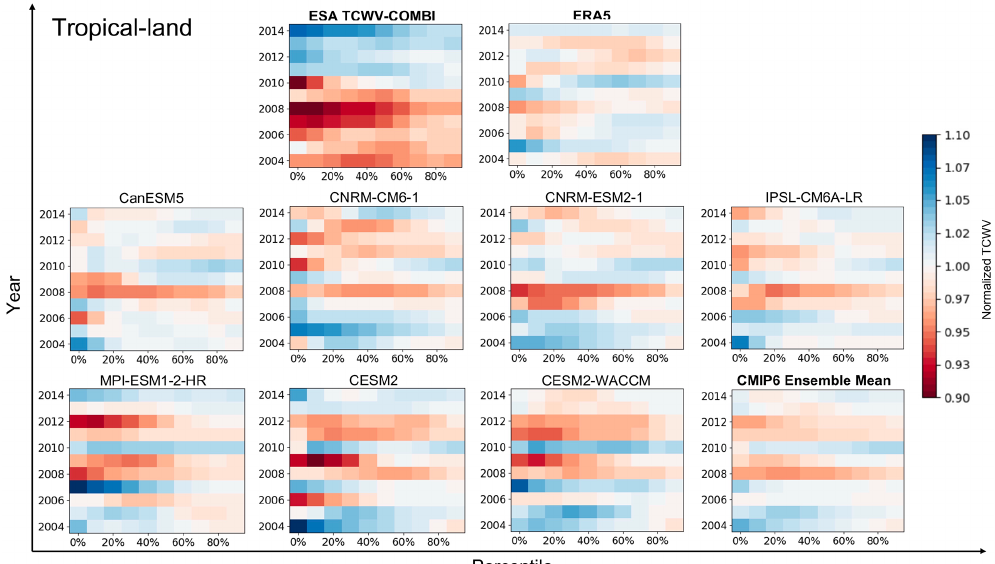
Figure 5. Normalized percentiles of the TCWV over land areas for every data record. The percentiles are grouped into bins of 10% intervals. The x axis represents the percentiles intervals, and the y axis represents the year. Note that the period starts in 2004 instead of 2003 to focus on full